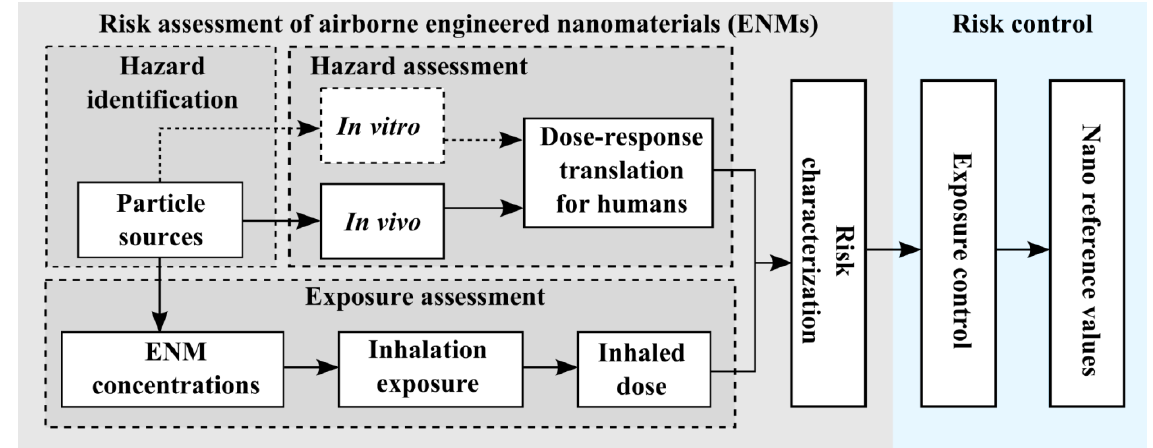
Figure 1. Principal steps of ENM risk assessment: identify particle sources, assess ENM hazard and exposure levels, and characterize risk of the ENM exposure. Exposure control measures are based on the risk level which can be used to estimate an upper limit on the acceptable ENM concentration in workplace